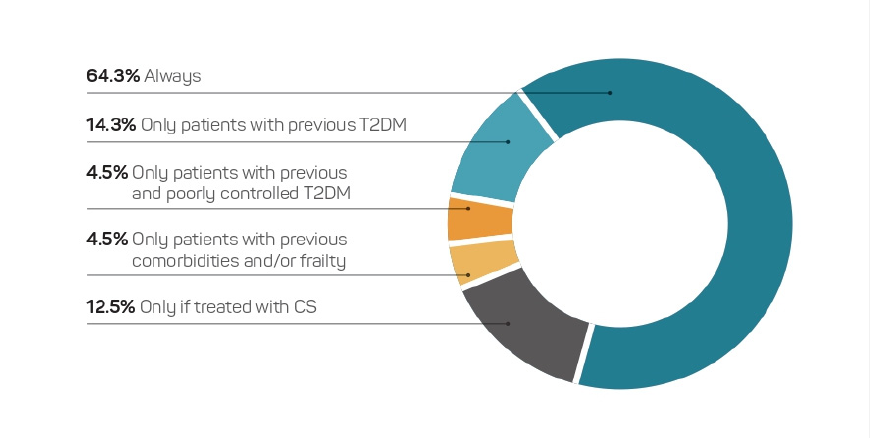
Figure 1. Opinion on whether patients with COVID-19 have a higher risk of glycaemic decompensation ( n = 112). CS, Corticosteroids.